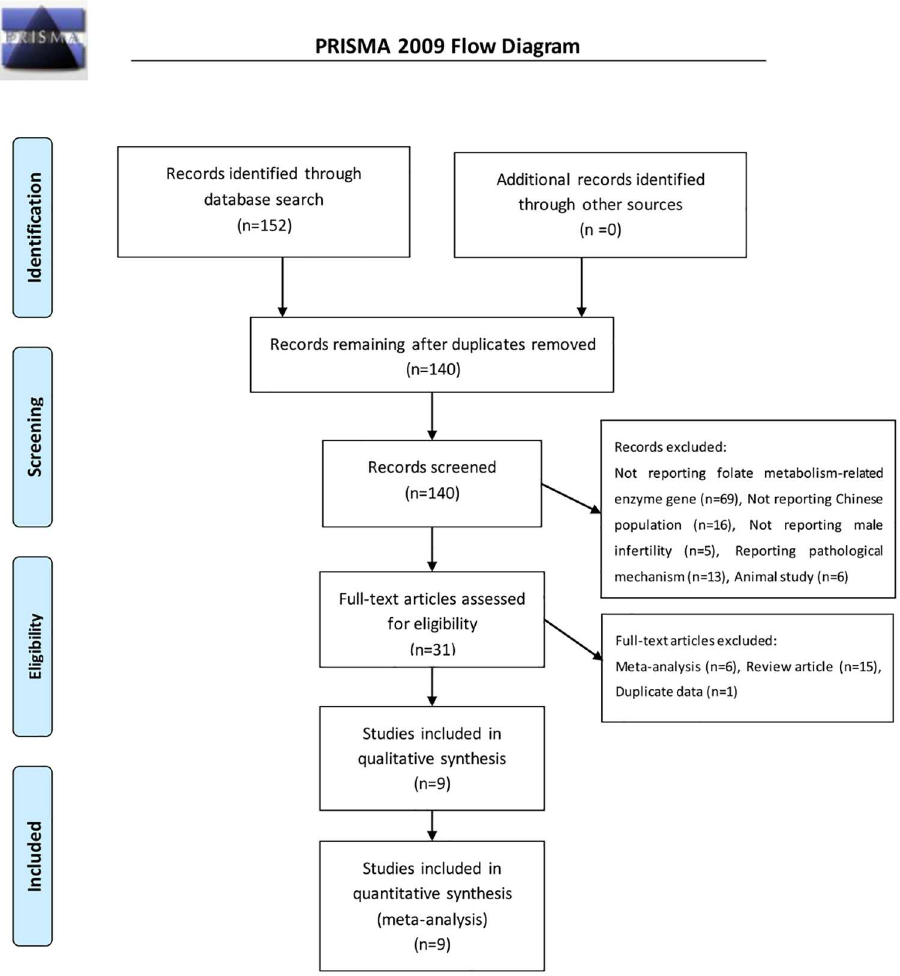
Fig 1. Flowchart of the study selection